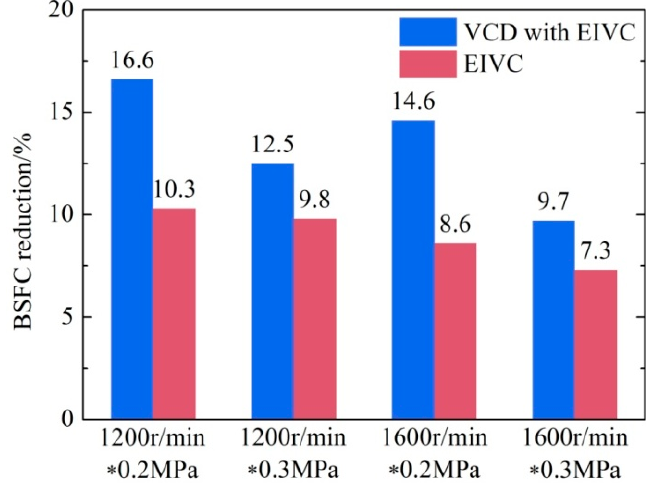
Figure 22. Benefits to fuel economy achieved by VCD operations.